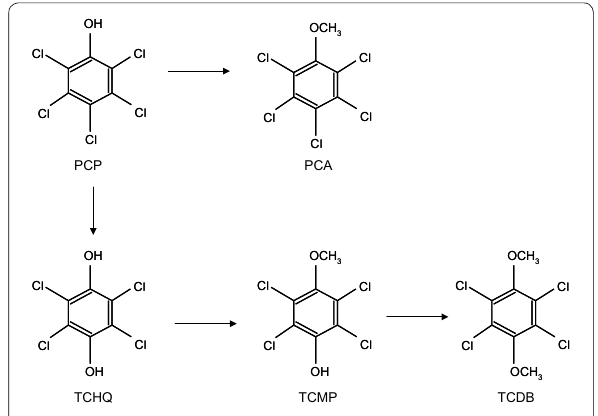
Fig. 3 Proposed partial pathways for the degradation of PCP by P.